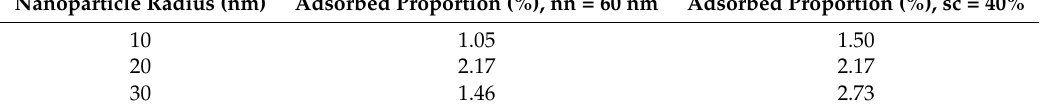
Table 3. The adsorbed proportion of the fibrinogen main body in simulations with flat surfaces with attached nanoparticles with different radii for a fixed distance between centers of nearest neighbors (nn) and a fixed surface coverage of nanoparticles (sc). The surface charge density for the flat surface and the nanoparticles is − 0.001 e /Å 2